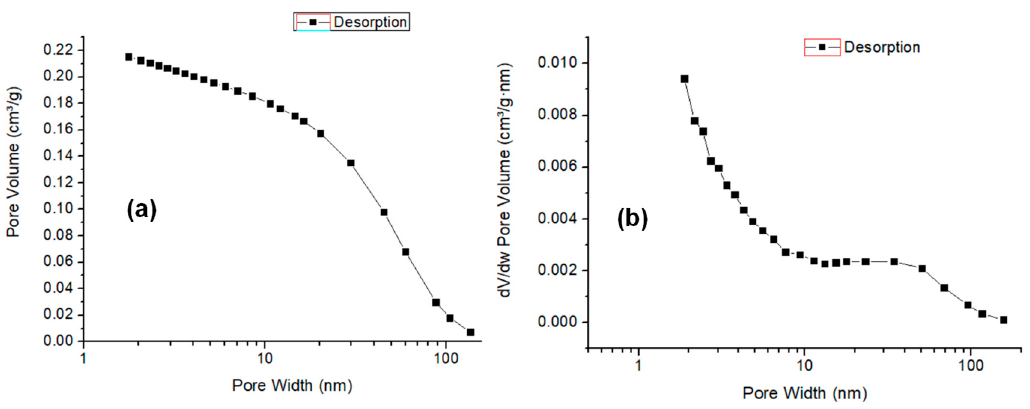
Figure 5. ( a ) Pore volume(cm 3 /g) vs. pore width (nm) and ( b ) dV/dw Pore volume (cm 3 /g·nm) vs. pore width (nm) calculated by Barrett–Joyner–Halenda (BJH) model on the isotherm desorption branch of PolyCat-Si.